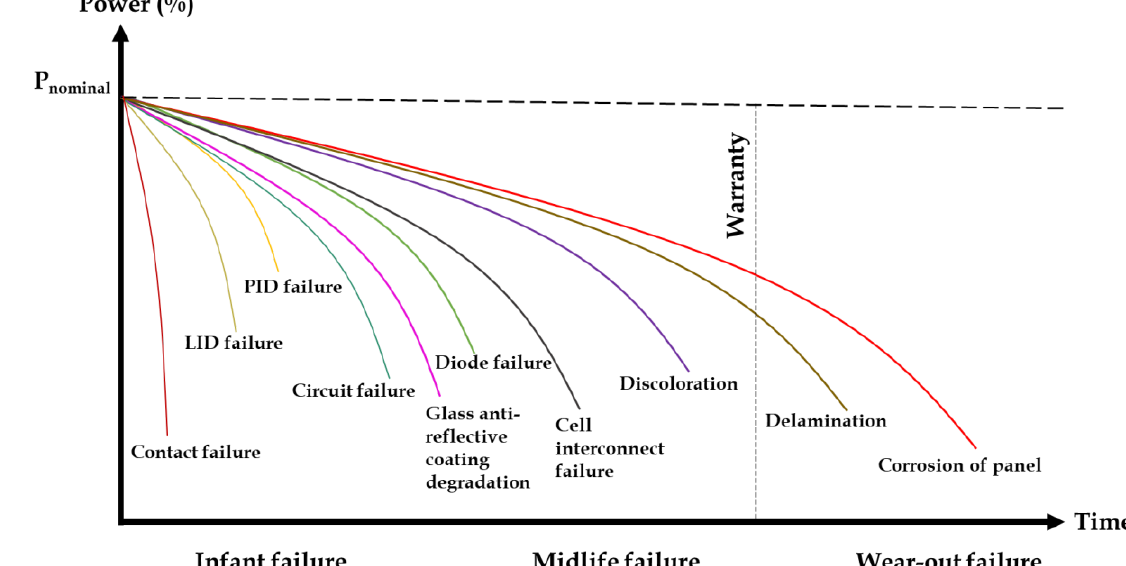
Figure 2. Possible faults that occur in the life cycle of PV panels.